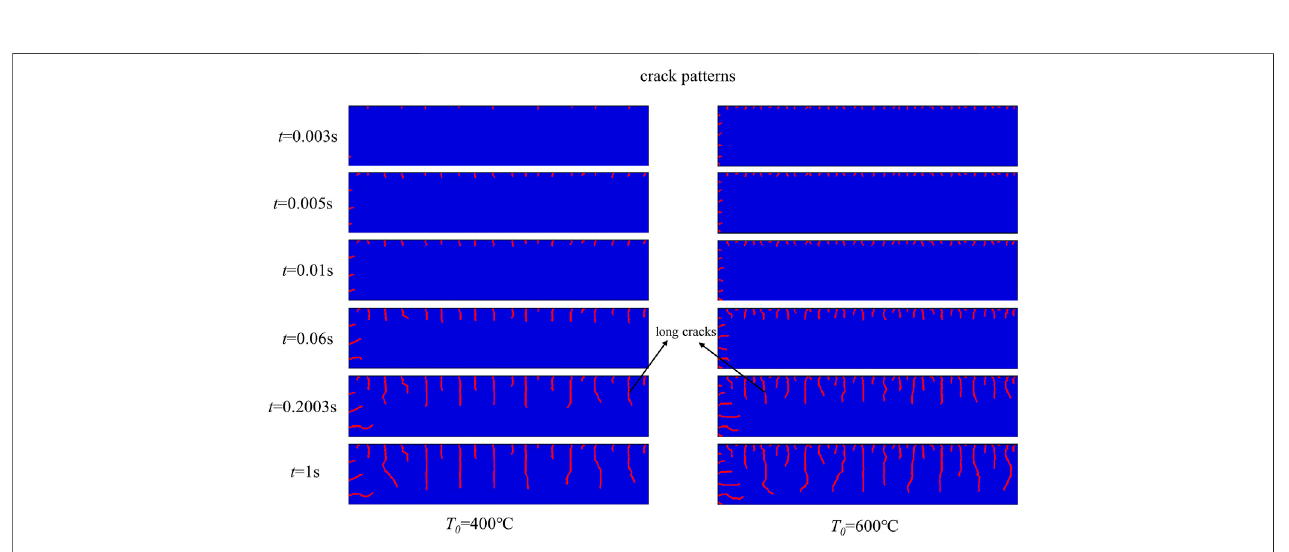
FIGURE 9 | Thermal shock crack evolution process of the rectangular Al 2 O 3 specimens under the initial temperatures of 400 and 600 ° C.